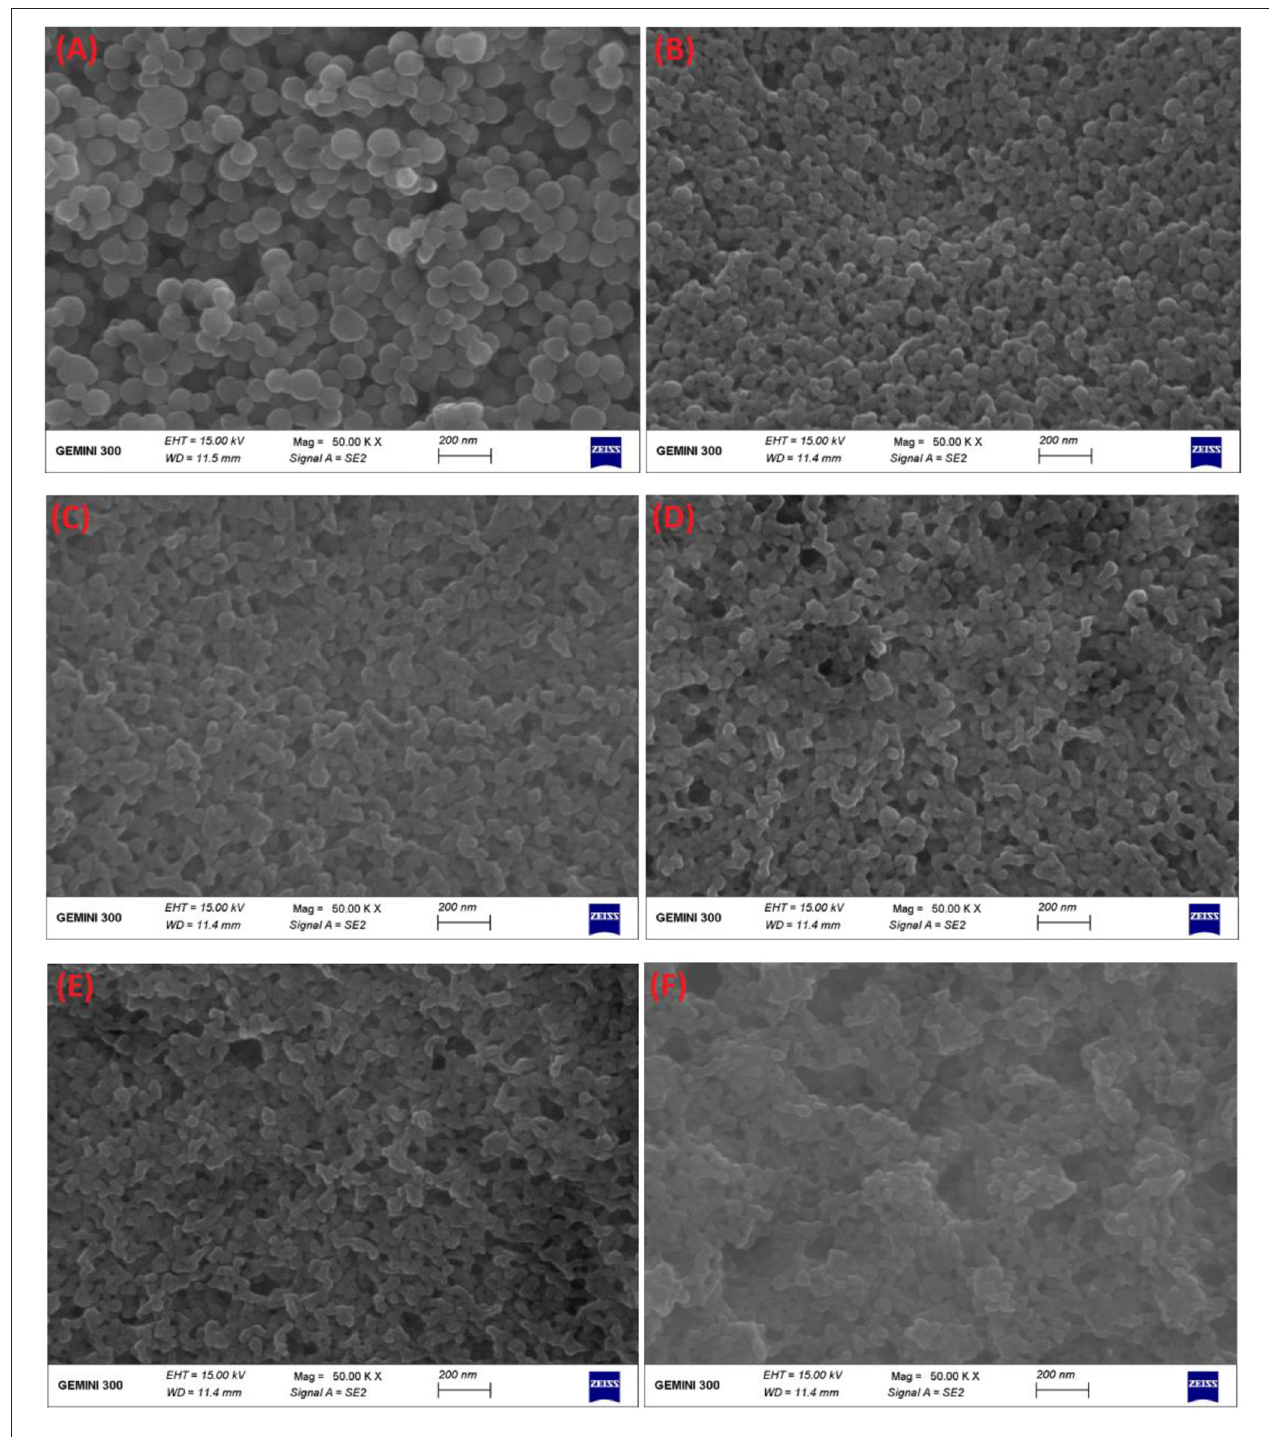
FIGURE 4 | Field emission scanning electron microscope (FE-SEM) images of bare zein nanoparticles (A) , DHF-zein (B) , DHF-zein/LF (C) , DHF-zein/LF 10K (D) , DHF-zein/LF 40K (E) , and DHF-zein/LF 70K (F) . Pictures were taken at × 50,000 magnifications.